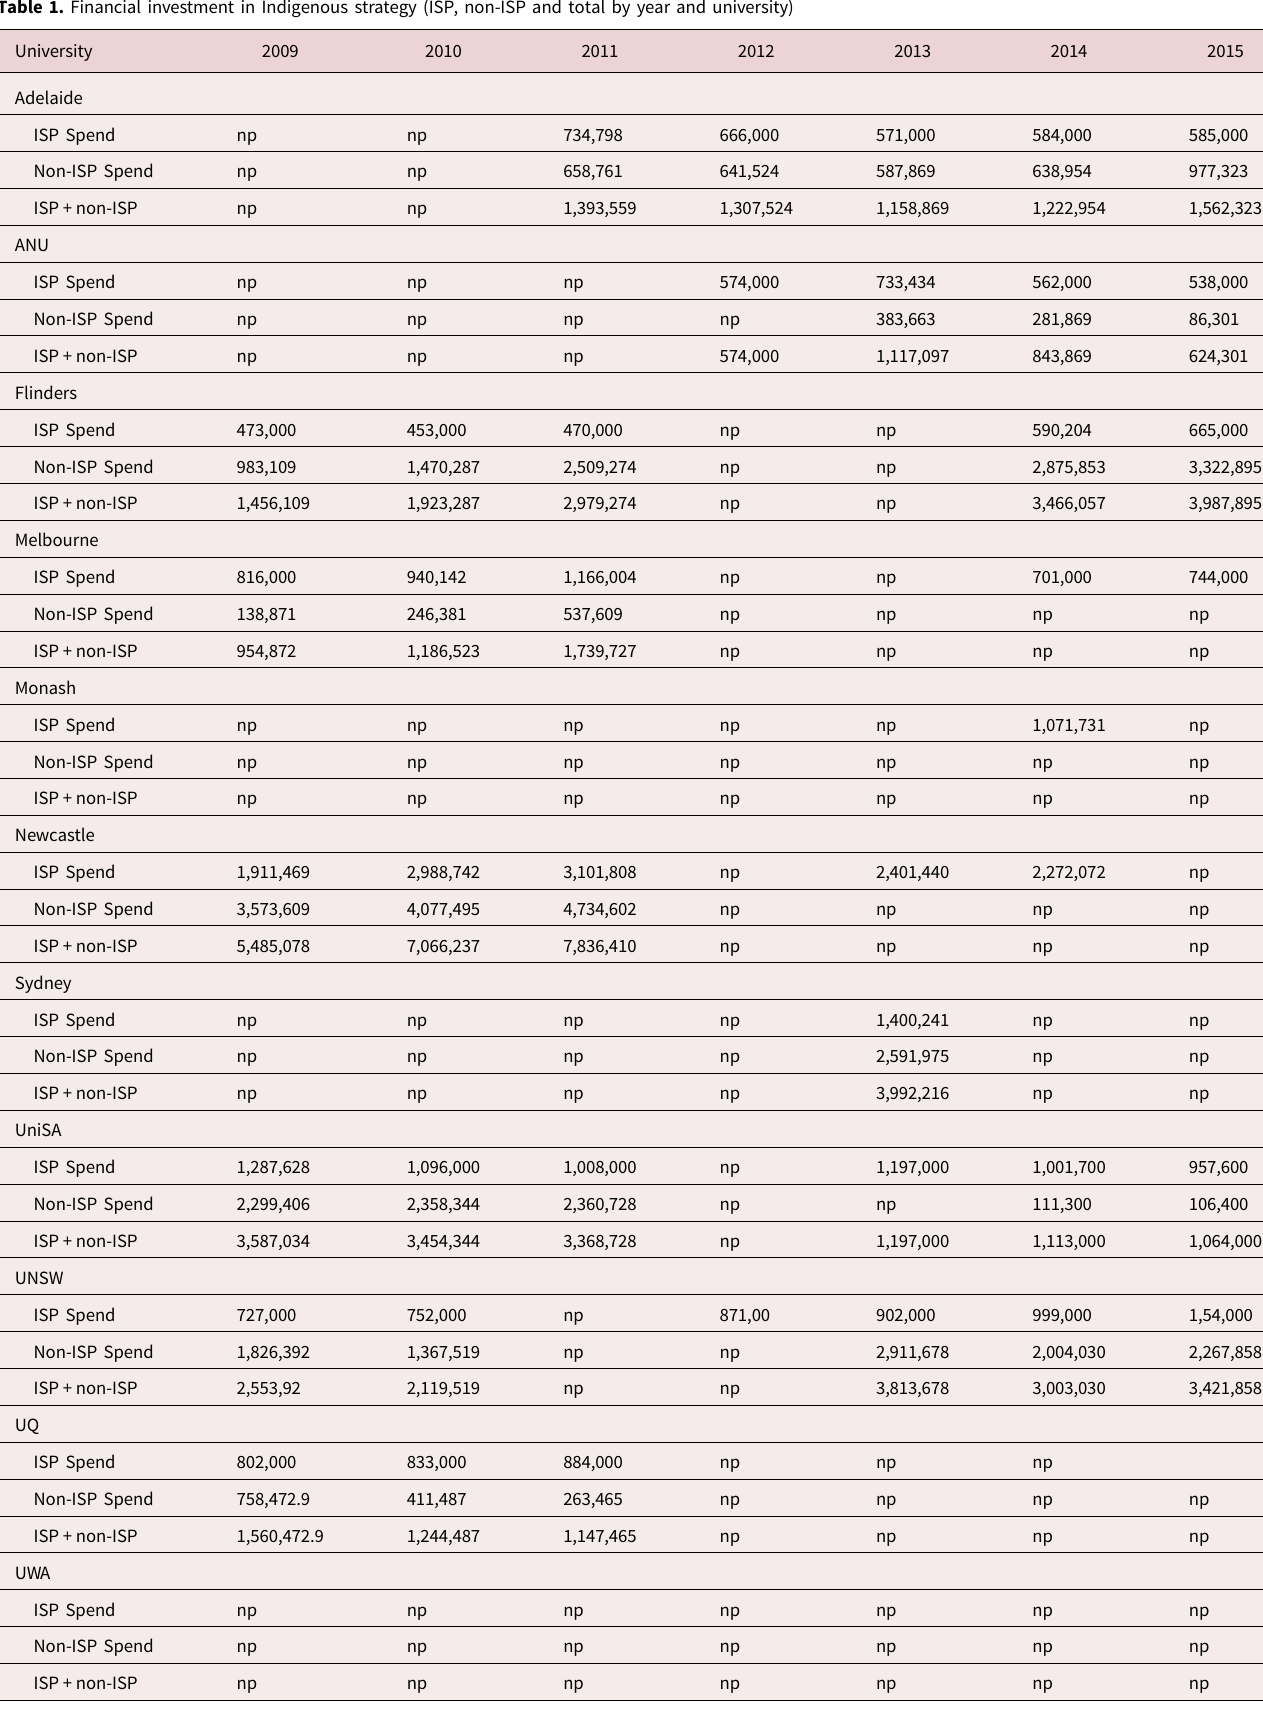
Table 1. Financial investment in Indigenous strategy (ISP, non-ISP and total by year and university)